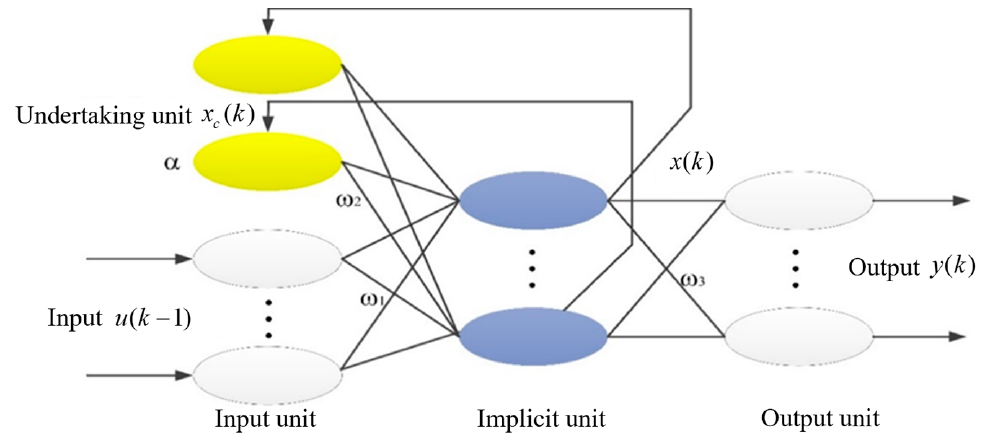
Figure 4. The structure of Elman network.